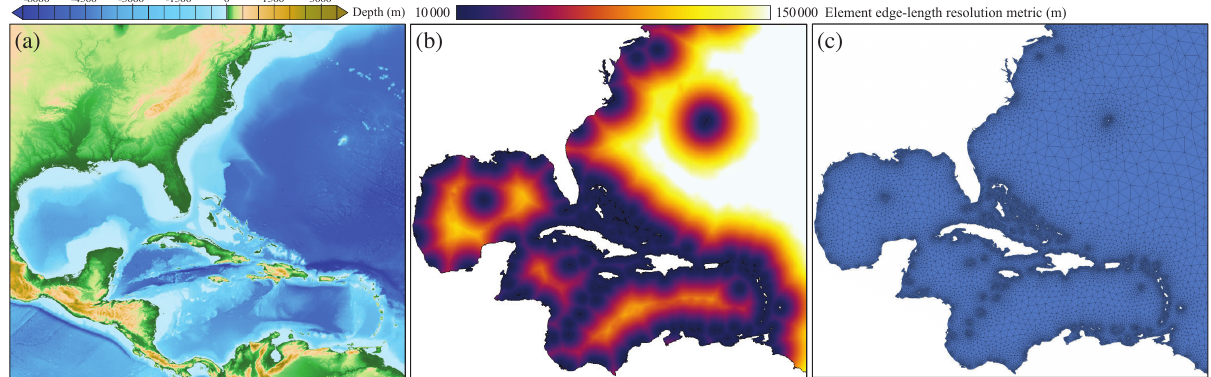
Figure 8. Simulation domain focused on the Caribbean Sea basin. (a) GEBCO (2014) DEM. (b) Surface geoid element edge-length resolution metric M h developed as a function of (a) . (c) Surface geoid boundary representation (cid:48) (cid:48) in blue, overlaid with multi-scale spatial discretisation T h